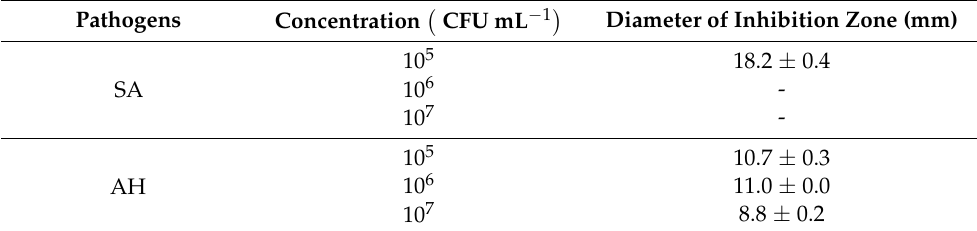
Table 1. Diameter of inhibition zones by Bacillus pocheonensis against Aeromonas hydrophila (AH) and Streptococcus agalactiae (SA) at three concentrations.